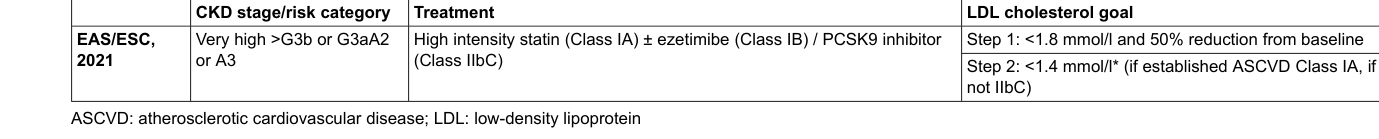
Table 6: Current recommendations on lipid lowering treatment in diabetes with chronic kidney disease [51]. CKD stage/risk category